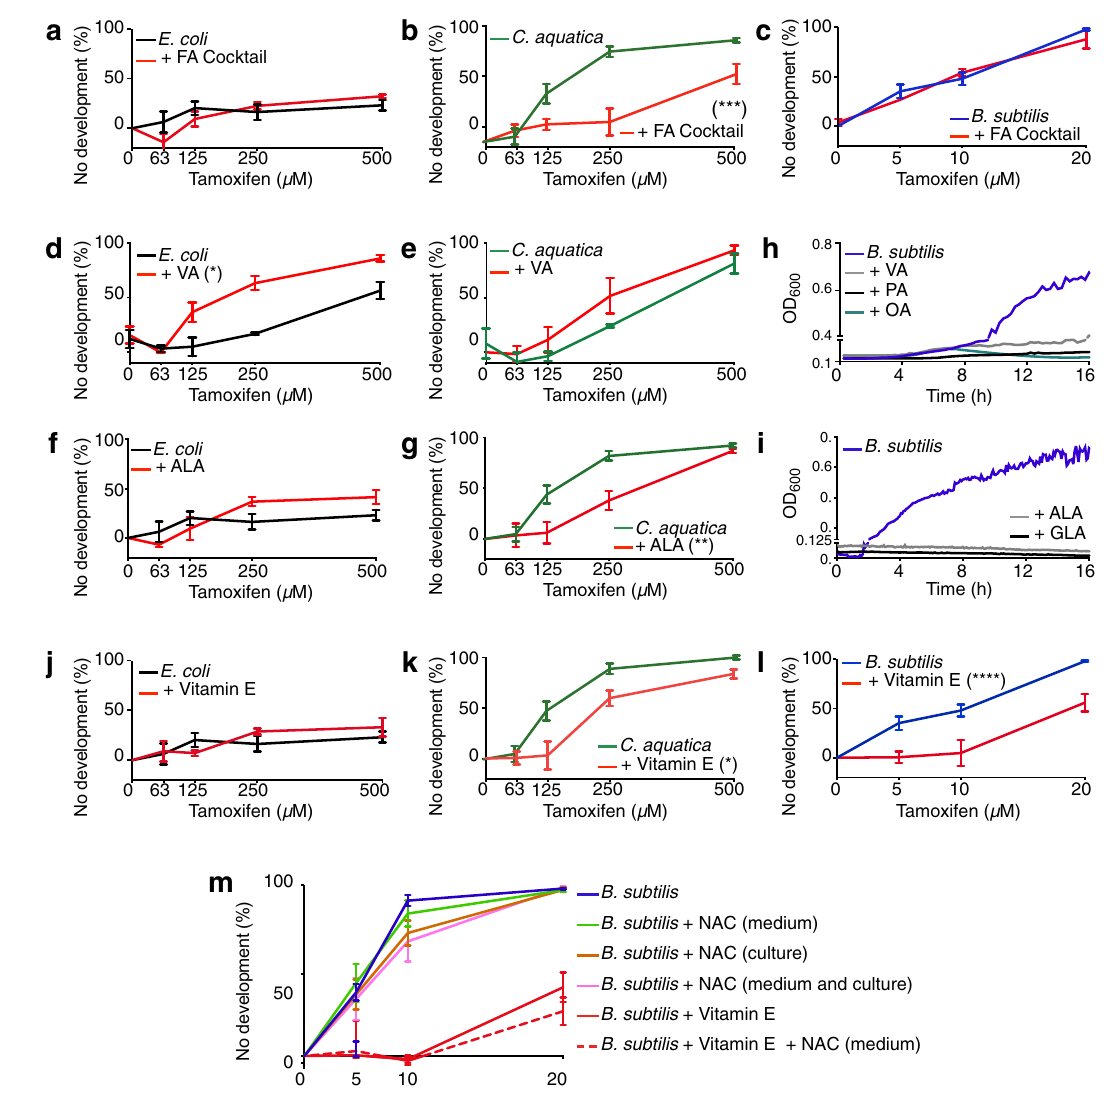
Fig. 5 | Long-chain fatty acid supplementation modulates tamoxifen toxicity. a – m Unless otherwise indicated, fatty acids and vitamin E were supplemented to the bacterialculturemedium asdescribed previously 75 , and data were represented as mean±SEM of three independent biological replicates. Statistical analysis of DRCswasconductedbyperformingatwo-wayANOVAfollowedbyaDunnettmulti- comparisontestusingtheno-supplementationconditionasacontrol,onGraphPad Prism (v9). a – c DRCs of tamoxifen toxicity with and without FA cocktail supple- mentation on animals fed E. coli ( a ), C. aquatica ( b ), or B. subtilis ( c ). Adjusted p values: 0.9401 ( a ),0.0003( b ),and 0.9345( c ). d , e DRCs oftamoxifen toxicitywith and without MUFA (VA) supplementation on animals fed E. coli ( d ) or C. aquatica ( e ). Adjusted p values : <0.0001 ( d ) and 0.0708 ( e ). f Growth curves of B. subtilis supplementedwithPUFAsALAorGLA.Forclarity,noerrorbarsarereportedinthe graph. f , g DRCs of tamoxifen toxicity with and without PUFA (ALA) supple- mentation on animals fed E. coli ( f ) or C.aquatica ( g ).Adjusted p values: 0.9556 ( f